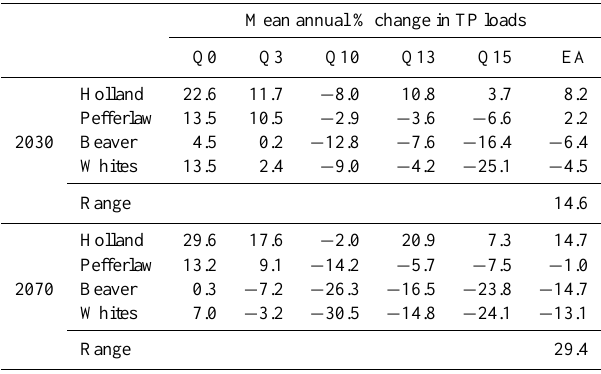
Table 8. Annual change in total phosphorus loads between base- line and future periods, for all ensemble members of the perturbed physics ensemble. Includes ensemble average (EA) change